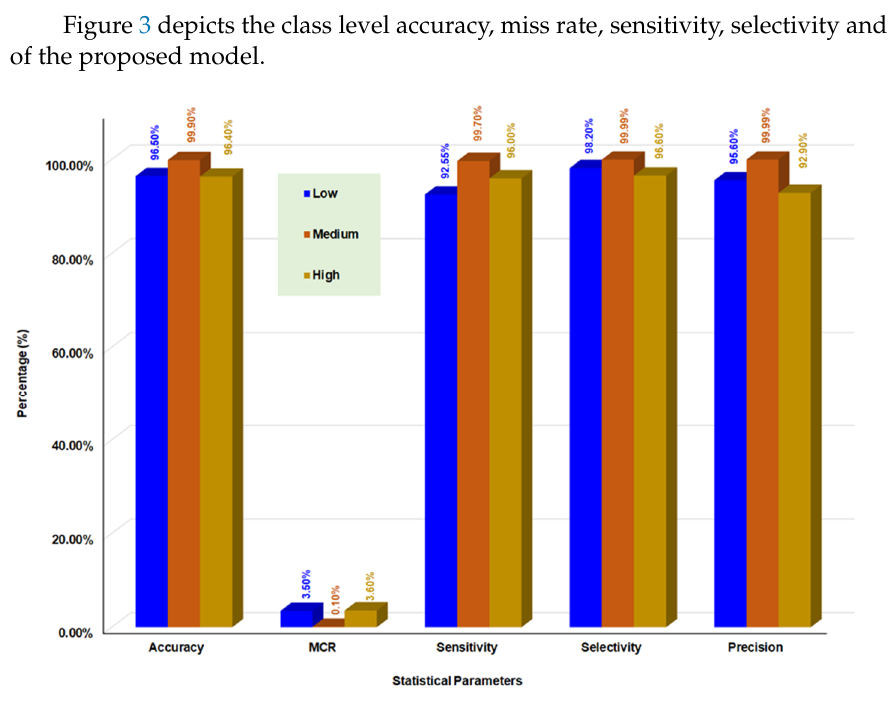
Figure 4. The overall accuracy and MCR for hydrogen storage prediction using the proposed HSPS- WFML model. Table 4 presents the comparison of the current work with the existing studies. It is observed from Table 4 that the accuracy of our proposed HSPS-WFML model is in agree- ment with the previous studies.